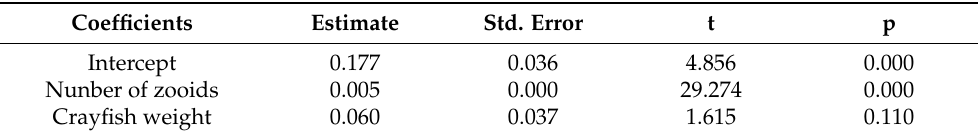
Table 1. Multiple regression analysis of oxygen consumption vs. number of zooids in gills and crayfish body weight.